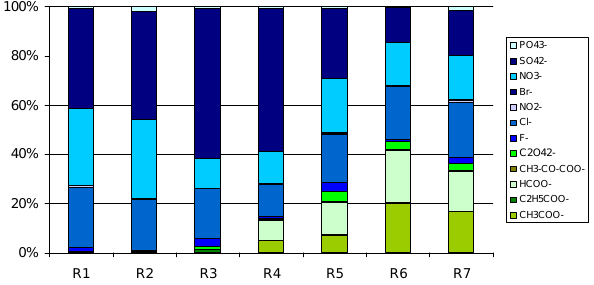
Fig. 6. Distribution of the median equivalent contribution to the measured anion load (%) of the rainwater samples. The organic anions appear in green and the inorganic anions in